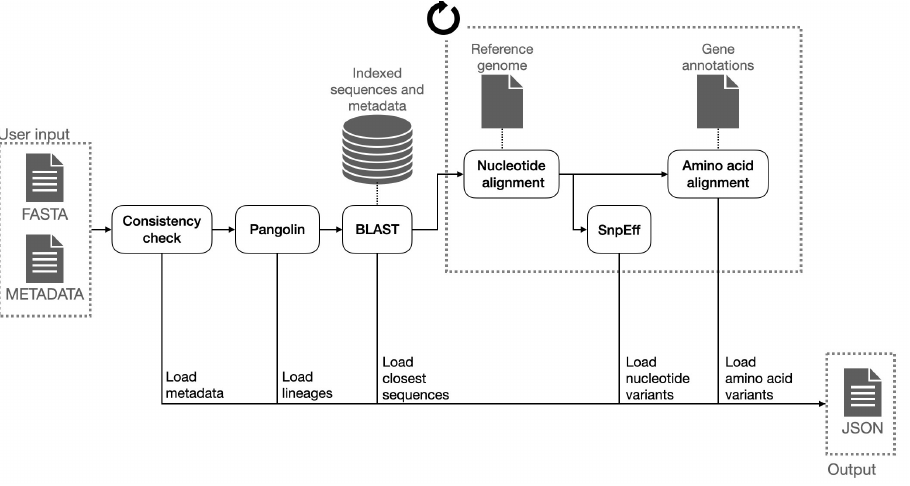
Figure 3. Consensus sequence analysis